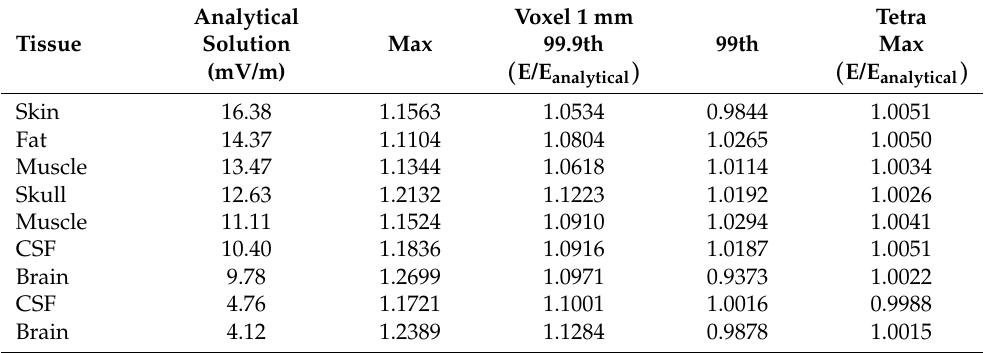
Table 2. Deviation between analytical and computed induced electric field on tetrahedral and voxel-based